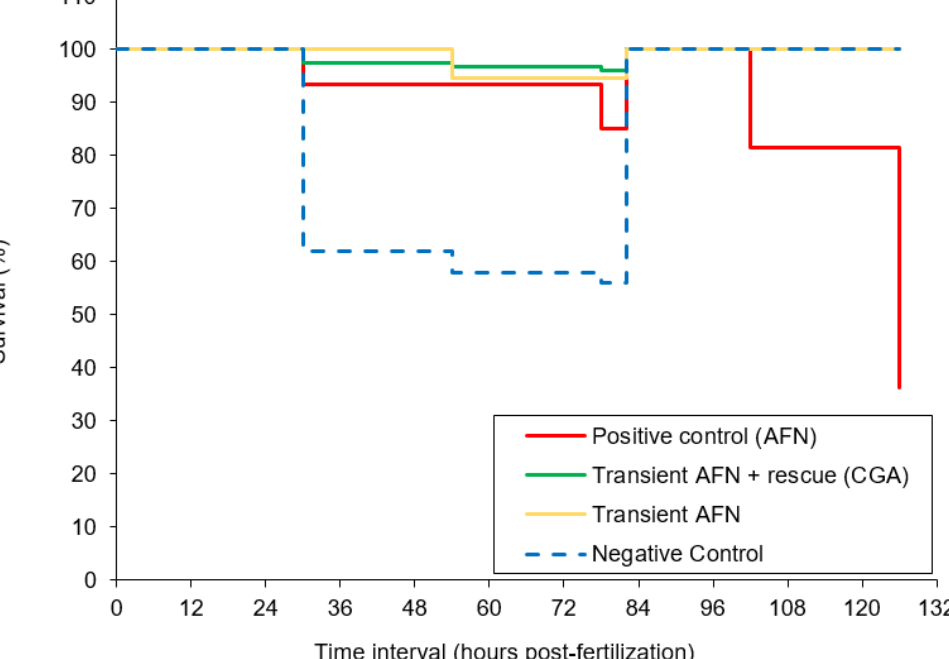
Figure 3. Kaplan-Meier analysis on the survival rate of zebrafish embryos transiently exposed to AFN followed by chlorogenic acid supplementation. Data are means ± SEM ( n = 84–237). Dechorination occurred at 84 hpf.